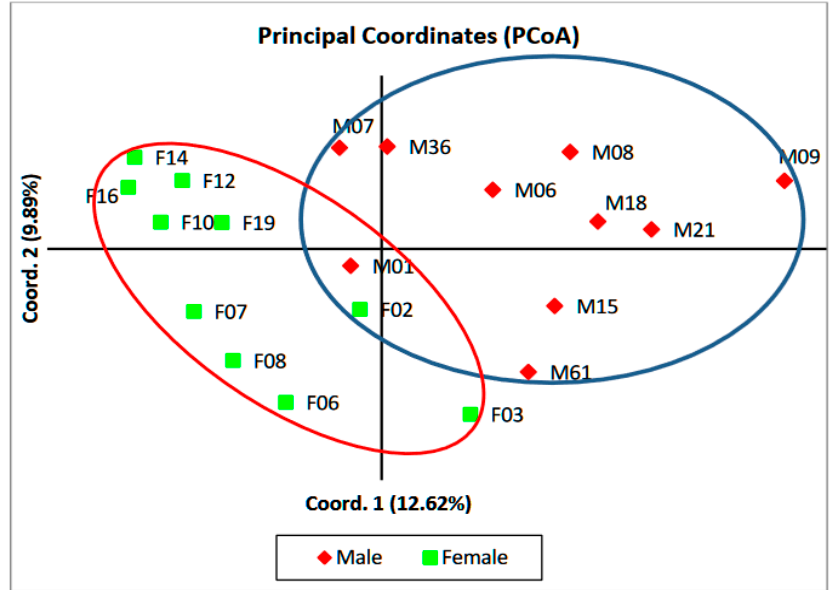
Figure 9. Principal coordinates analysis (PCoA) derived from bands amplified by eight ISSR